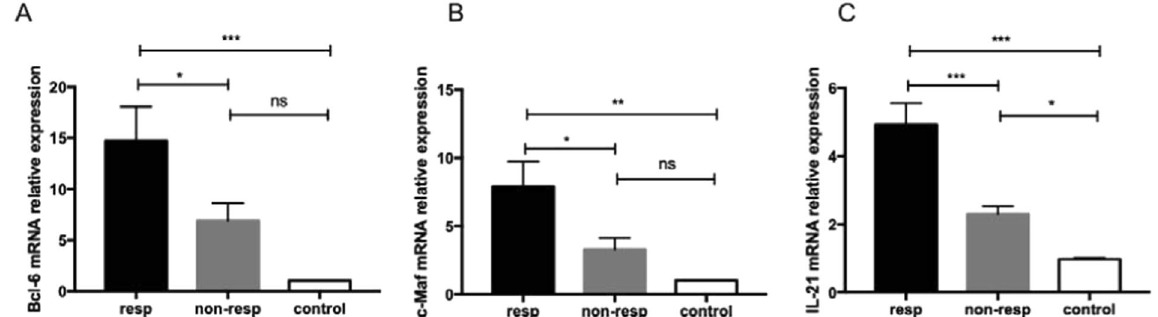
Figure 5. Expression of Bcl-6, c-Maf, and IL-21 mRNA in Tcells of the AIHA mouse model. ( A ) Levels of the relative expression of Bcl-6 mRNAof T cells from mice in the responder, non-responder, and control groups. ( B ) Levels of the relative expression of c-Maf mRNA of CD4 + T cells from these three groups. ( C ) Levels of the relative expression of IL-21 mRNA of CD4 + T cells from these three groups. Experiments were repeated three times with 3–4 mice in each group. Data shown were the mean ± SEM. * p < 0.05; ** p < 0.01; *** p <